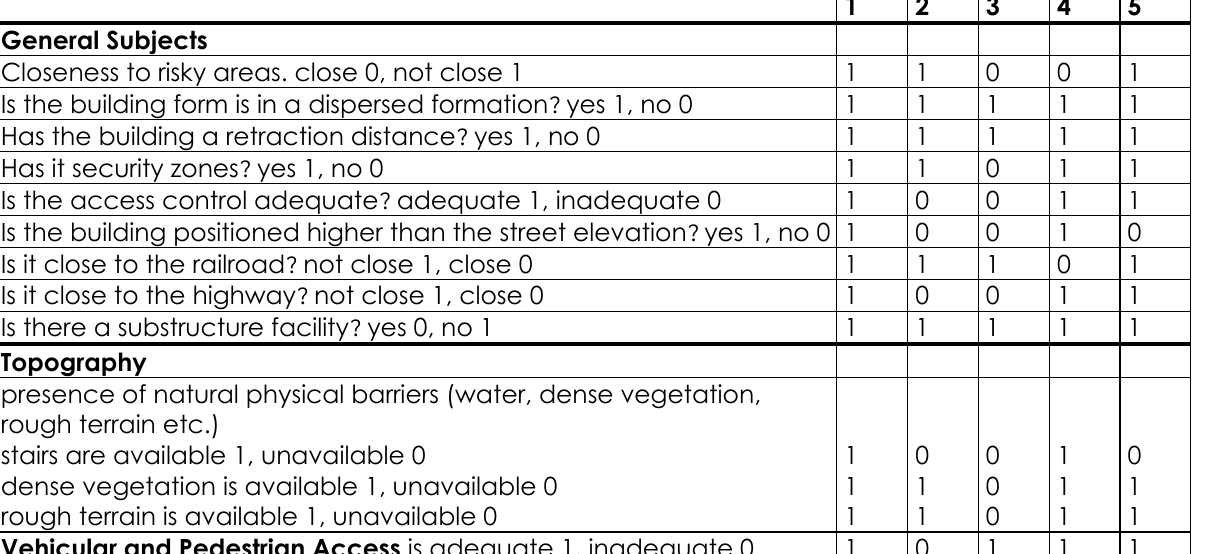
Table 2. Score Analysis of Shopping Centers (LATIS, 2016; FEMA, 2007; FEMA,